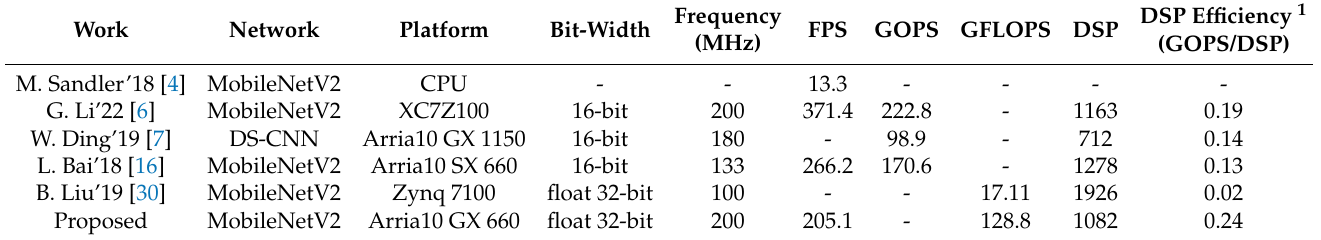
Table 3. Comparison of performance with pervious FPGA-based accelerators and traditional platforms.